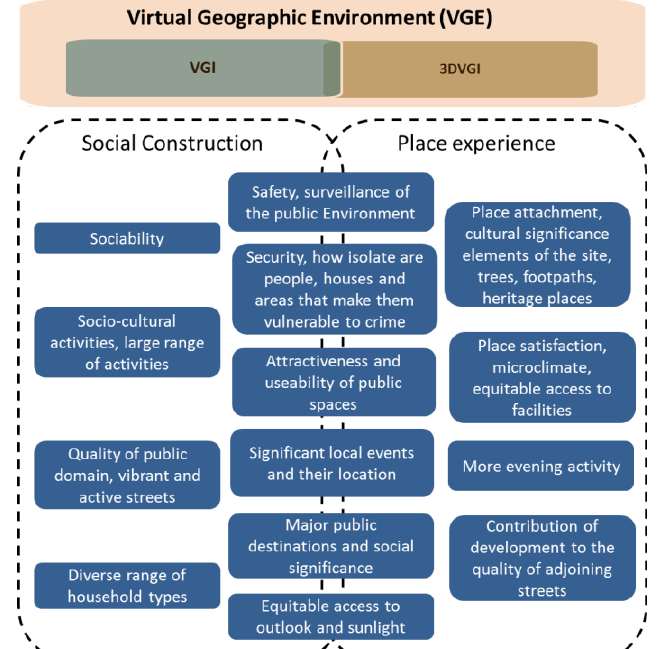
Figure 4. Measuring subjective aspects of building and neighbourhood using VGI and 3DVGI in a virtual geographic envi-